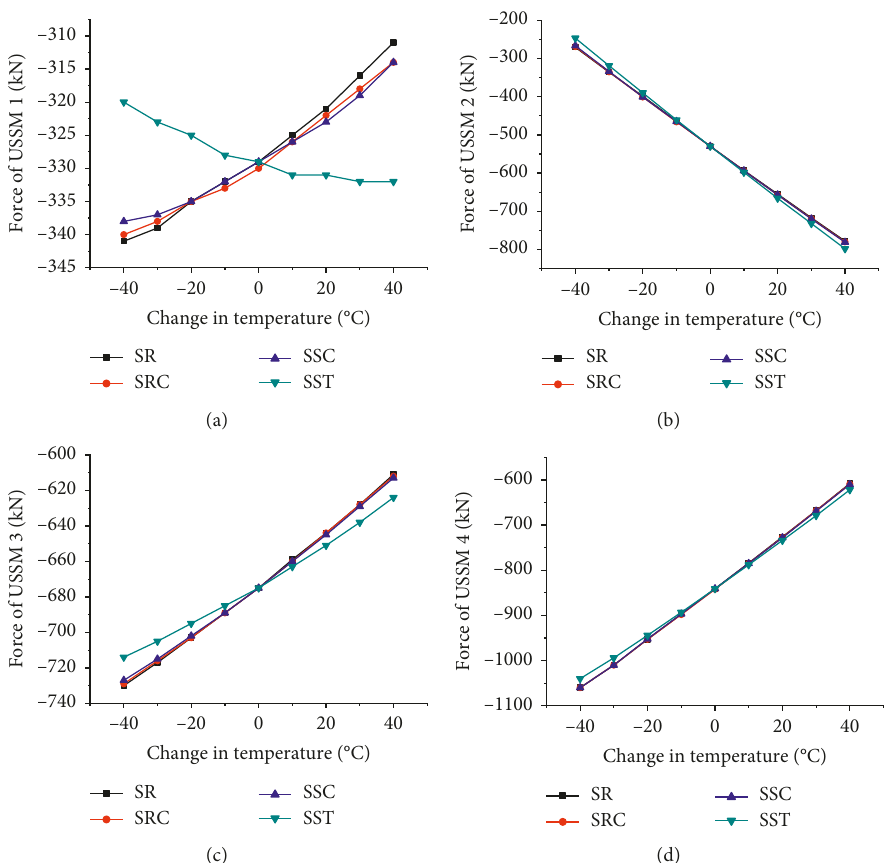
Figure 6: Relationship between the force at the upper structural steel members and the temperature in the full-span load distribution. Change in the force of (a) USSM 1, (b) USSM 2, (c) USSM 3, and (d) USSM 4 with varying